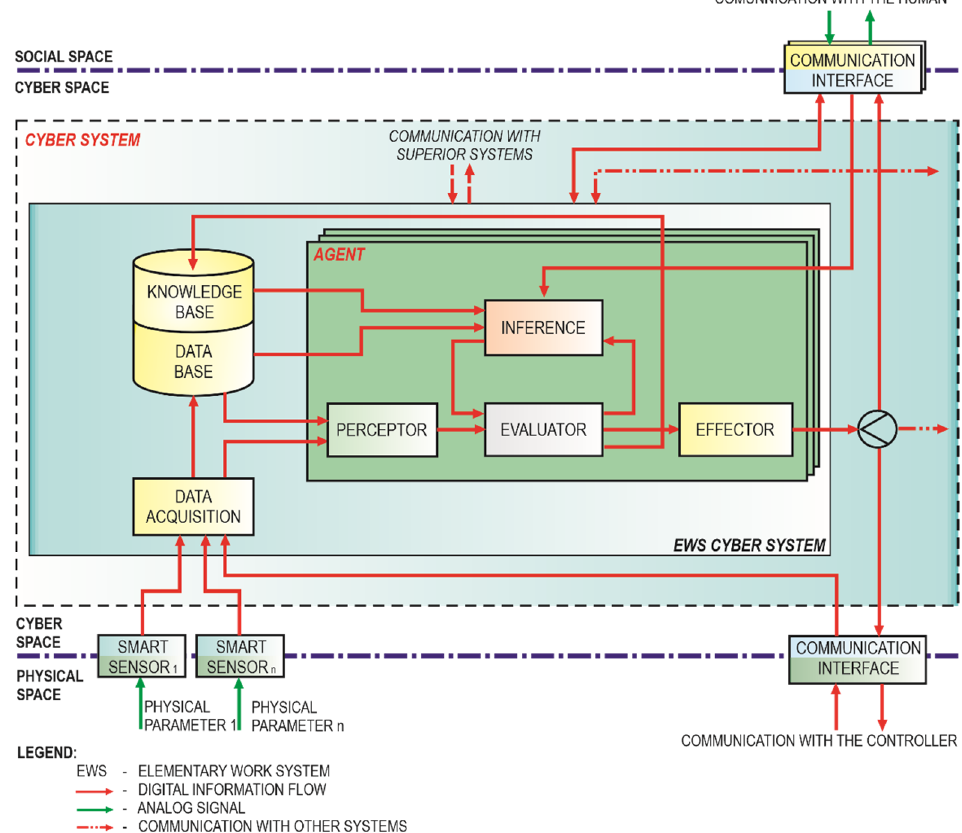
Figure 16. EWS cyber systems of the CPPS in the C-CPPS concept.